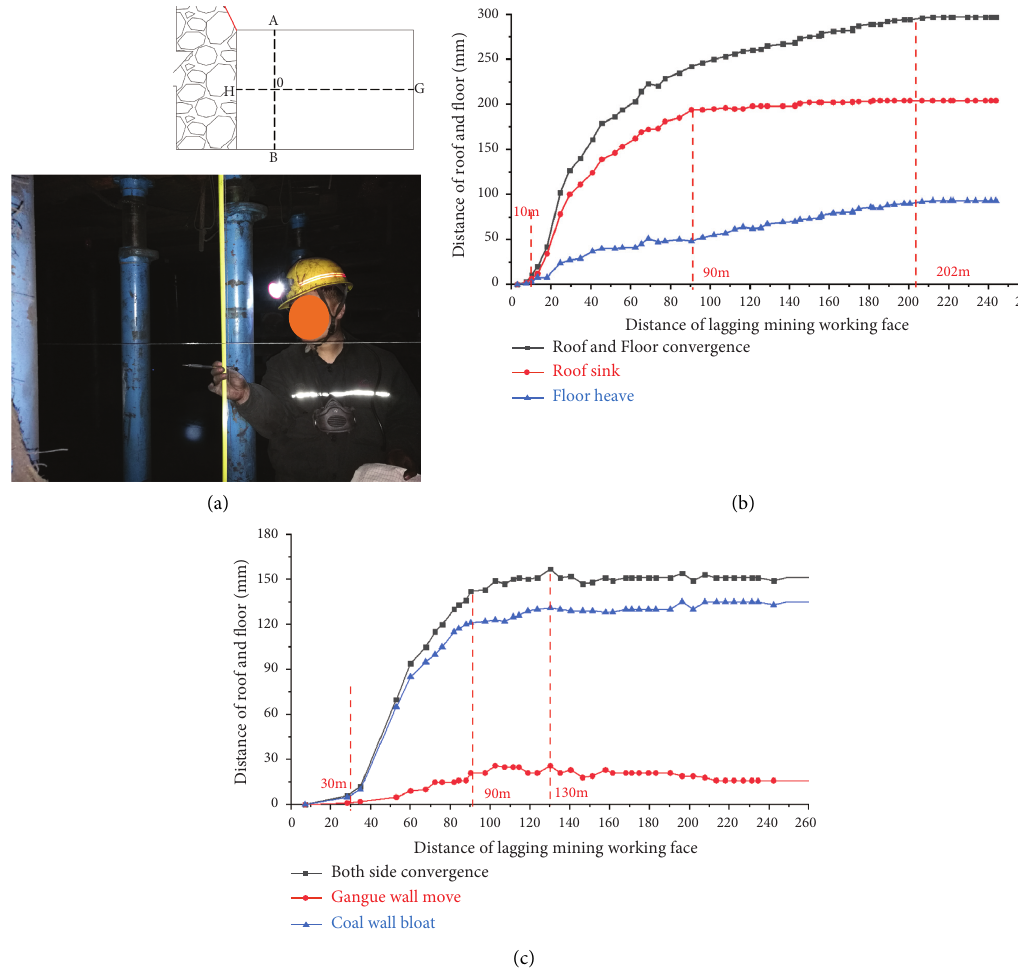
Figure 15: Displacement measurement of the roadway. (a) The cross-point measurement method of on-site workers. (b) Roof and floor deformation curve of the roadway. (c) Two sides deformation curve of the